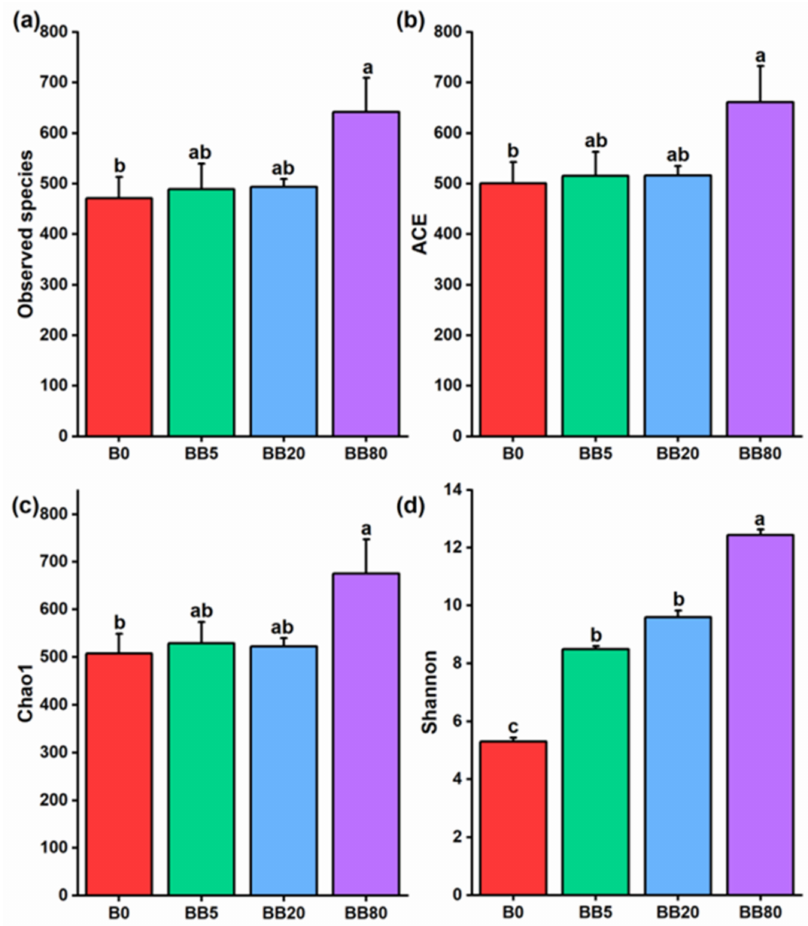
Figure 3. The alpha diversity of soil fungal species. The different alpha diversity indices were calculated under different bamboo biochar concentrations: ( a ) Observed species; ( b ) ACE index; ( c ) Chao1 index; ( d ) Shannon diversity index. The bar graphs with different lowercase letters show significant differences between various treatments (LSD test, p < 0.05). B0, BB5, BB20, and BB80 represent different bamboo biochar concentrations of 0, 5, 20, and 80 g kg − 1 ,